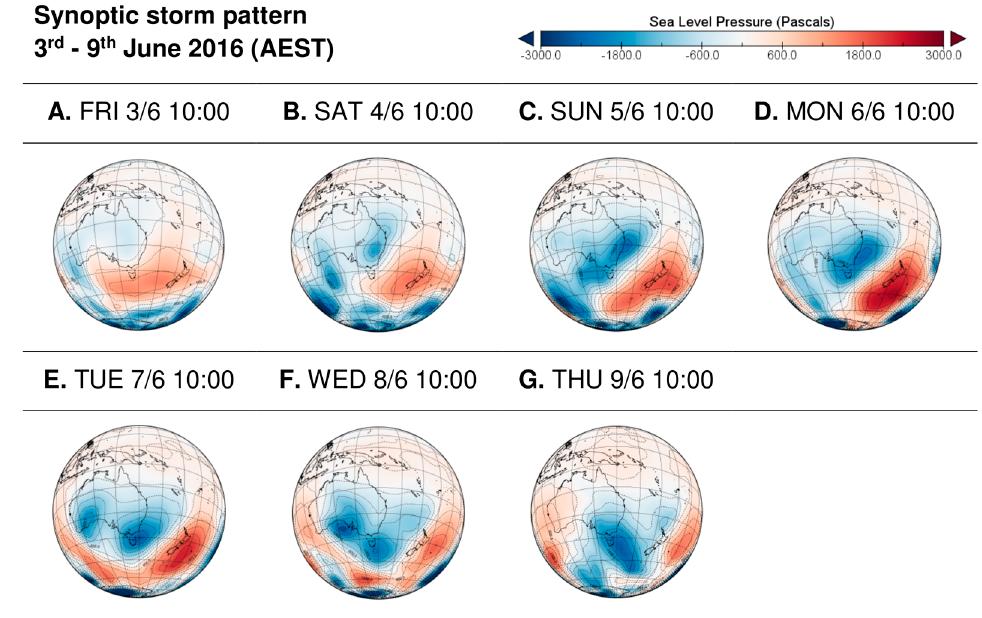
Figure 6. Sea level pressure patterns over the Tasman Sea every 24 h from 3 to 9 June 2016 from the NCEP/NCAR reanalysis at a 2.5° resolution [37]. High pressure (red) is associated with anti ‐ cyclonic winds and low pressure (blue) is associated with cyclonic winds. The low ‐ pressure trough that formed in ( A ) and ( B ) was directed down the length of the New South Wales coast in ( C , D ) and into Tasmania in ( E ) by the anticyclone that intensified over New Zealand. Only when the anticyclone migrated eastwards into the South ‐ West Pacific in ( F ) could the low ‐ pressure cell move off the coast into the South Tasman Sea ( G ).